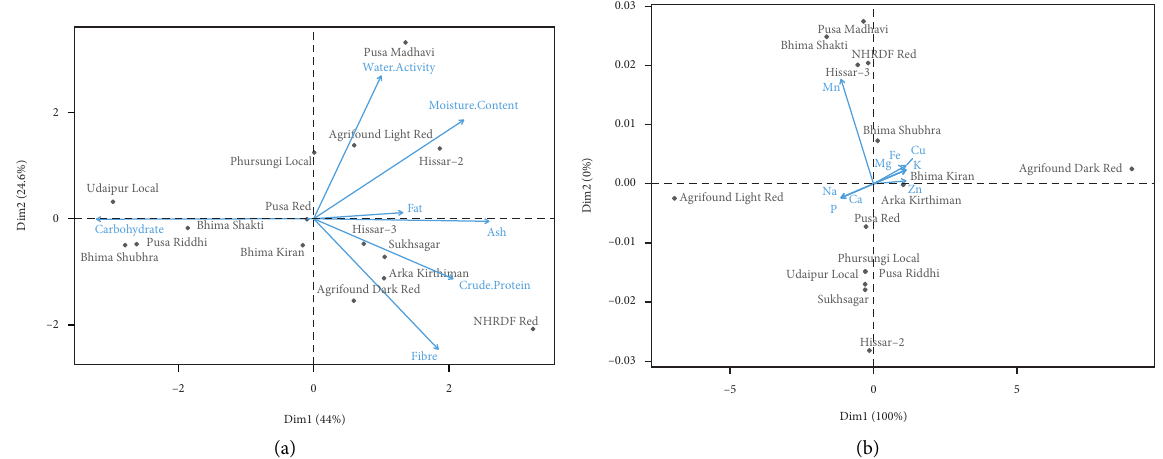
Figure 1: Principal Component Analysis biplots for (a) proximate composition and (b) mineral